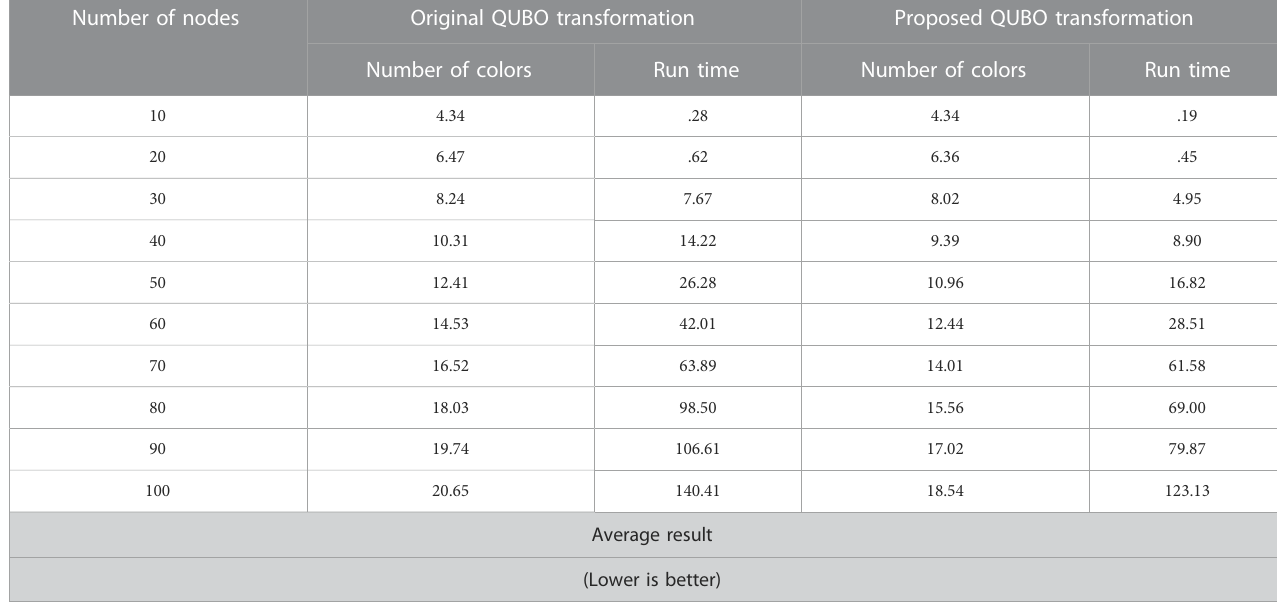
TABLE A1 Comparison of the proposed QUBO transformation for the graph coloring problem to original QUBO transformation described in [7]. Number of nodes Original QUBO transformation Proposed QUBO